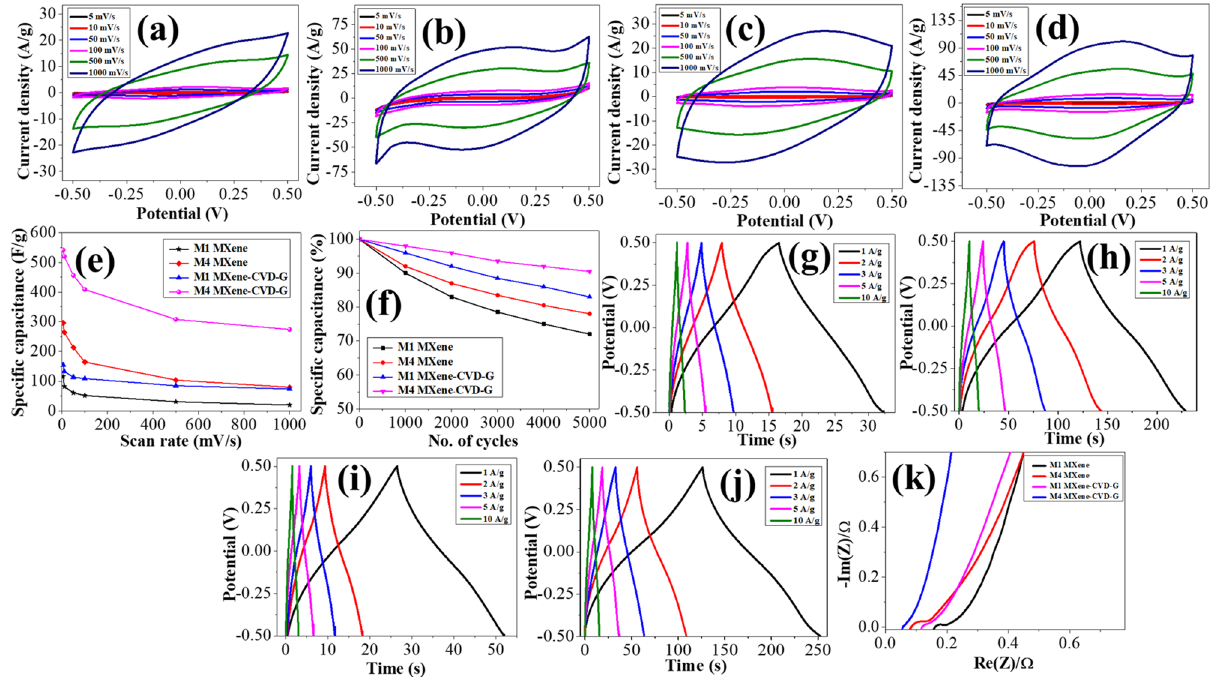
Figure 4. Electrochemical characteristics of the supercapacitors ( a , b ) CV curves without CVD-G and ( c , d ) with CVD-G for M1 and M4 MXene, respectively. ( e ) Capacitance retention at various scan rates. ( f ) Cyclic stability at 1000 mV/s till 5000 cycles. GCD curves without CVD-G ( g , h ) and with CVD-G ( i , j ) for M1 and M4, respectively. ( k ) Nyquist plots for M1 and M4 Ti 3 C 2 T x MXene with and without Figure 4 summarizes the electrochemical characteristics of the M1 and M4 MXene based supercapacitors. The specific capacitance (capacitance/g or C g ) of the M1 and M4 MXene based two-electrode systems were estimated using CV plots recorded in a range from − 0.5 to 0.5 V at various scan rates ranged from 5 to 1000 mV/s (Slow scan rate magnified CV curves (5 and 10 mV/s) are shown in Supporting information Figure S6a–d). In this study, the purpose is to measure the capacitance in the potential window 1 V (− 0.5 to + 0.5 V) as it is known that for the aqueous acidic electrolytes the permitted voltage window is ~ 1.2 V. At a slow scan rate, 5 mV/s, the redox peaks were observed at around − 0.1 V and + 0.1 V indicating pseudo-capacitive behavior. Even at higher scan rates, such as 1000 mV/s the quasi-rectangular behavior was retained in all cases. However, it is more sig-